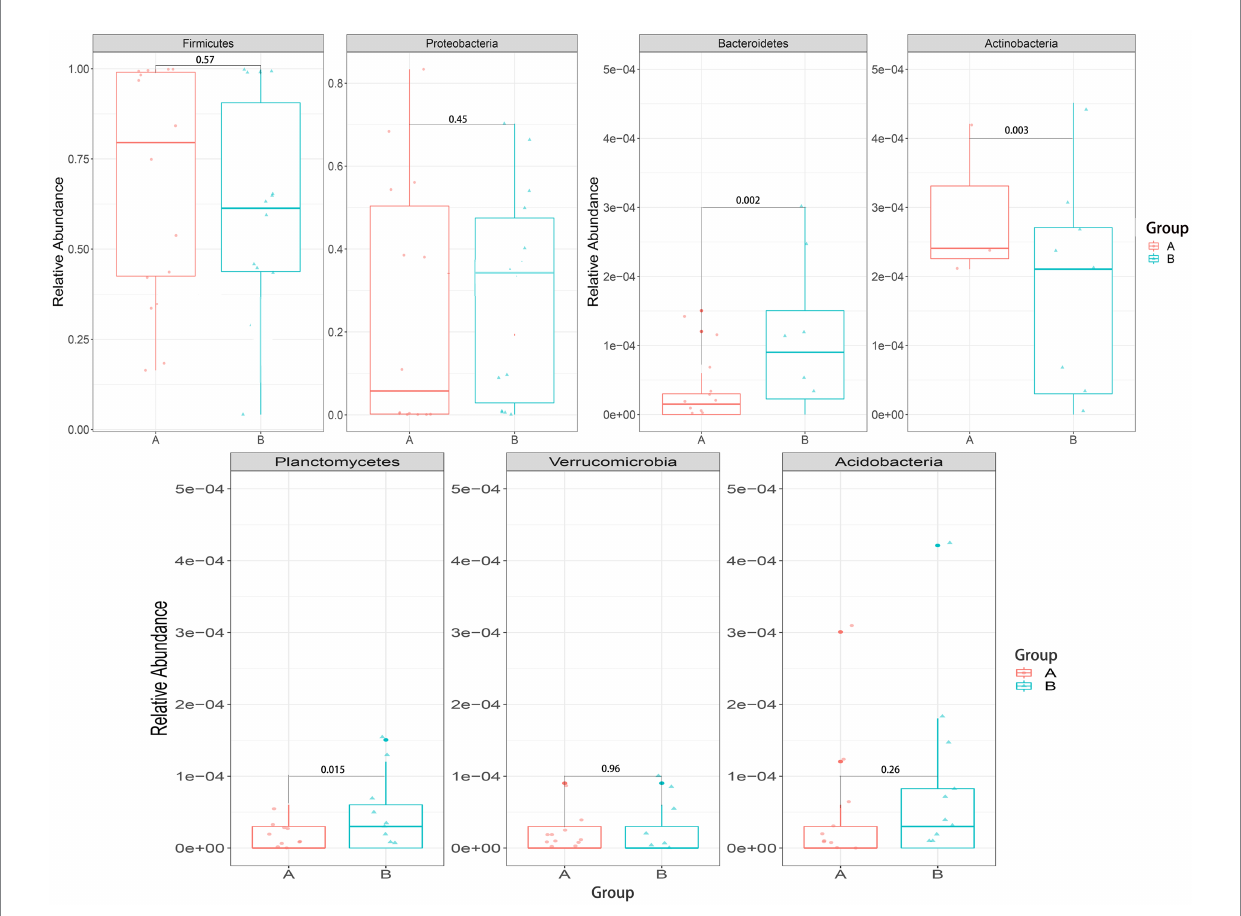
FIGURE 4 Differences in relative abundance between the two groups at the phylum